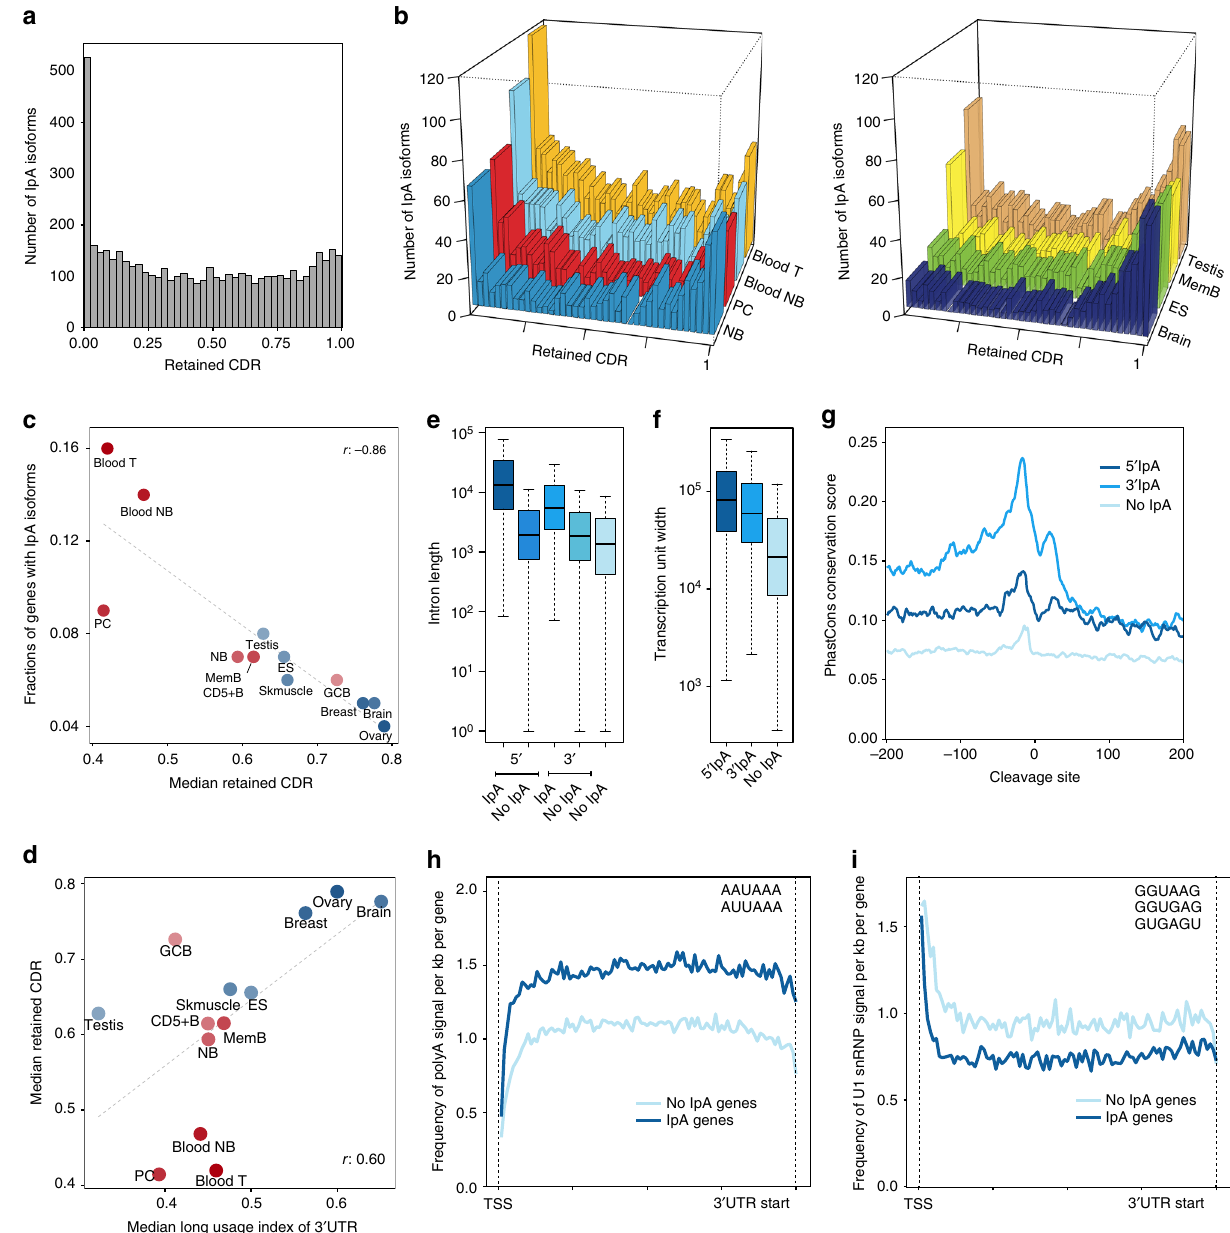
Fig. 2 Enrichment of IpA sites at the start of transcription units. a The fraction of retained coding region (CDR) was calculated as the nucleotides from the start codon to the end of the exon located upstream of the IpA peak, divided by all coding nucleotides of the longest annotated open reading frame and is shown for all IpA isoforms in the atlas. b As in a , but shown for individual cell types. c Correlation between the median retained CDR with the fraction of genes that generate IpA isoforms in each sample (Pearson's correlation coef fi cient, r = − 0.86). Tissues with a higher proportion of IpA isoforms generate IpA isoforms with shorter CDRs. d Correlation between the median retained CDR and the median usage of the distal ApA site in the 3 ʹ UTR (Pearson's correlation coef fi cient, r = 0.60). Tissues with shorter 3 ʹ UTRs have IpA isoforms with shorter CDRs. e IpA isoforms occur in long introns. The introns in which 5 ʹ IpA events occur are longer than the other introns of the same genes (one-sided Wilcoxon rank-sum test, P < 10 − 20 ). Similarly, the introns in which 3 ʹ IpA events occur are longer than the remaining introns of those genes (one-sided Wilcoxon rank-sum test, P < 10 − 20 ). If taken together, then the introns in which IpA events occur are longer than the introns of the genes that only express full-length isoform (one-sided Wilcoxon rank-sum test, P < 10 − 20 ). f IpA isoforms occur in genes with long transcription units. Genes that express IpA isoforms have longer transcription units compared to genes that only express full-length isoforms (one-sided Wilcoxon rank-sum test, P < 10 − 20 ). g Higher conservation around the cleavage sites of IpA isoforms. The plot shows PhastCons scores of 200 nt upstream and downstream of IpA cleavage sites ( x = 0). 5 ʹ IpA and 3 ʹ IpA events both have signi fi cantly higher conservation fl anking the cleavage site compared to corresponding regions of randomly selected polyA signals (AAUAAA) in introns lacking IpA events (one-sided Wilcoxon signed-rank test, P < 10 − 68 for both comparisons). h Genes with IpA isoforms ( n = 3481) are enriched for polyadenylation sites compared with genes that do no generate IpA isoforms ( n = 12,092) (one-sided Wilcoxon signed-rank test, P < 10 − 18 ). The frequency of polyadenylation sites was counted from the TSS to the beginning of the 3 ʹ UTR and is shown as the average number of signals per kb per gene. i As in h , but U1 binding sites are shown. IpA genes are depleted for U1 snRNP signals (one-sided Wilcoxon signed-rank test, P < 10 − 18